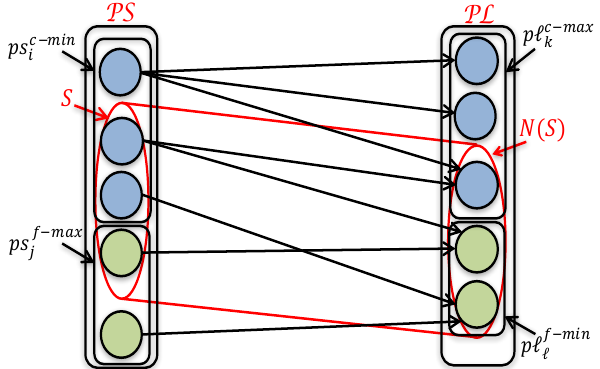
Figure 10. Illustration of a subset S of power sources and set N ( S ) of power loads.